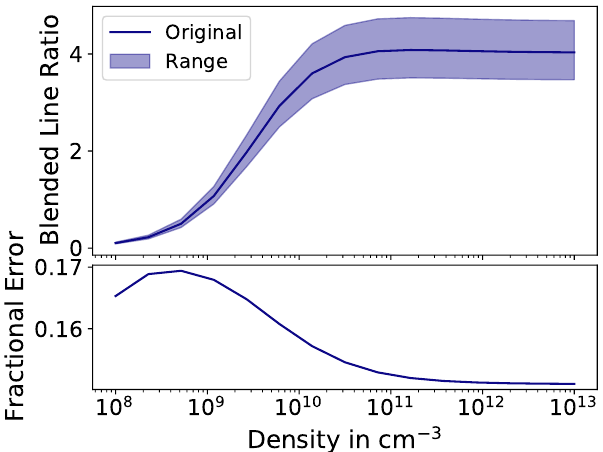
Figure 7. Blended Fe XIII line ratio (209.62 + 209.92) Å/213.77 Å versus density at Te = 200 eV. The final error on the line ratio is 16% for the entire temperature range ∼